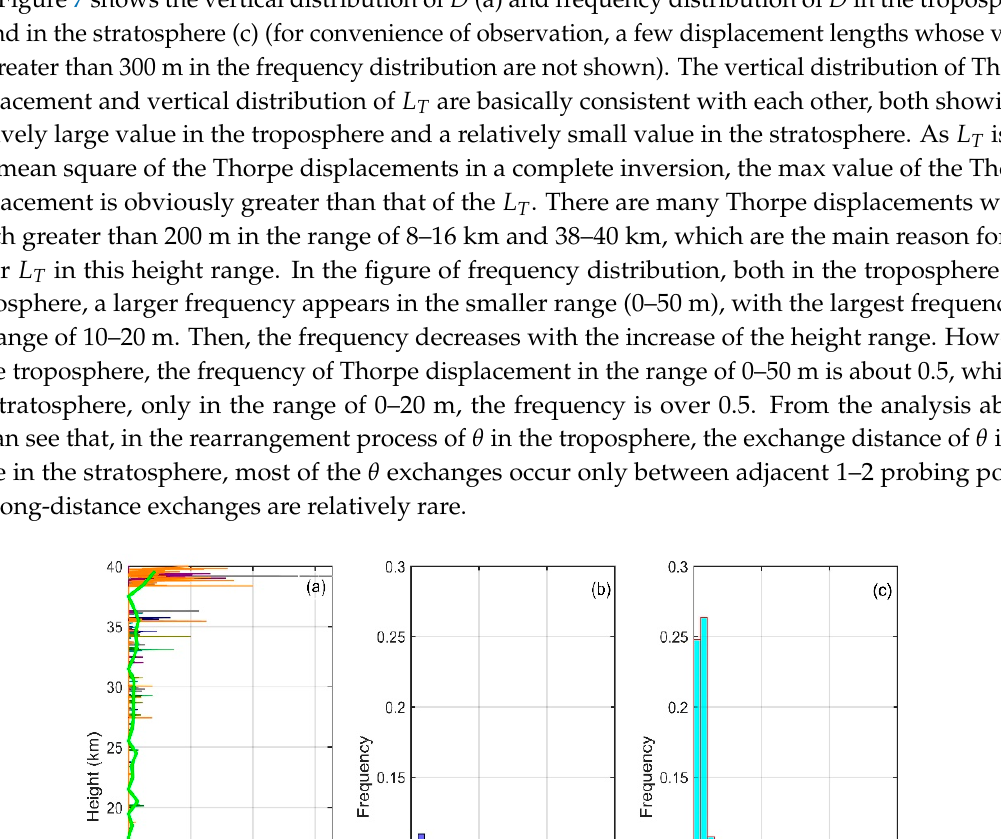
Figure 6. Wind profiles ( a ); windshear profiles ( b ); and Ri profiles ( c ) obtained from ERA-Interim data.